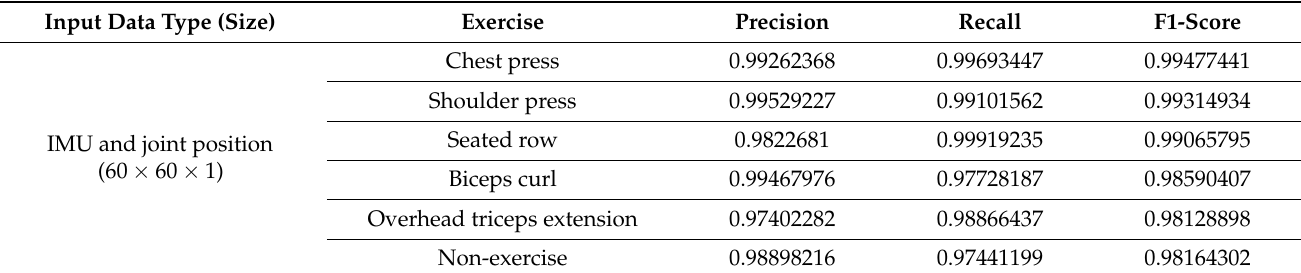
Table 12. Precision, recall, and F1-scores of the IMU and joint position input models.